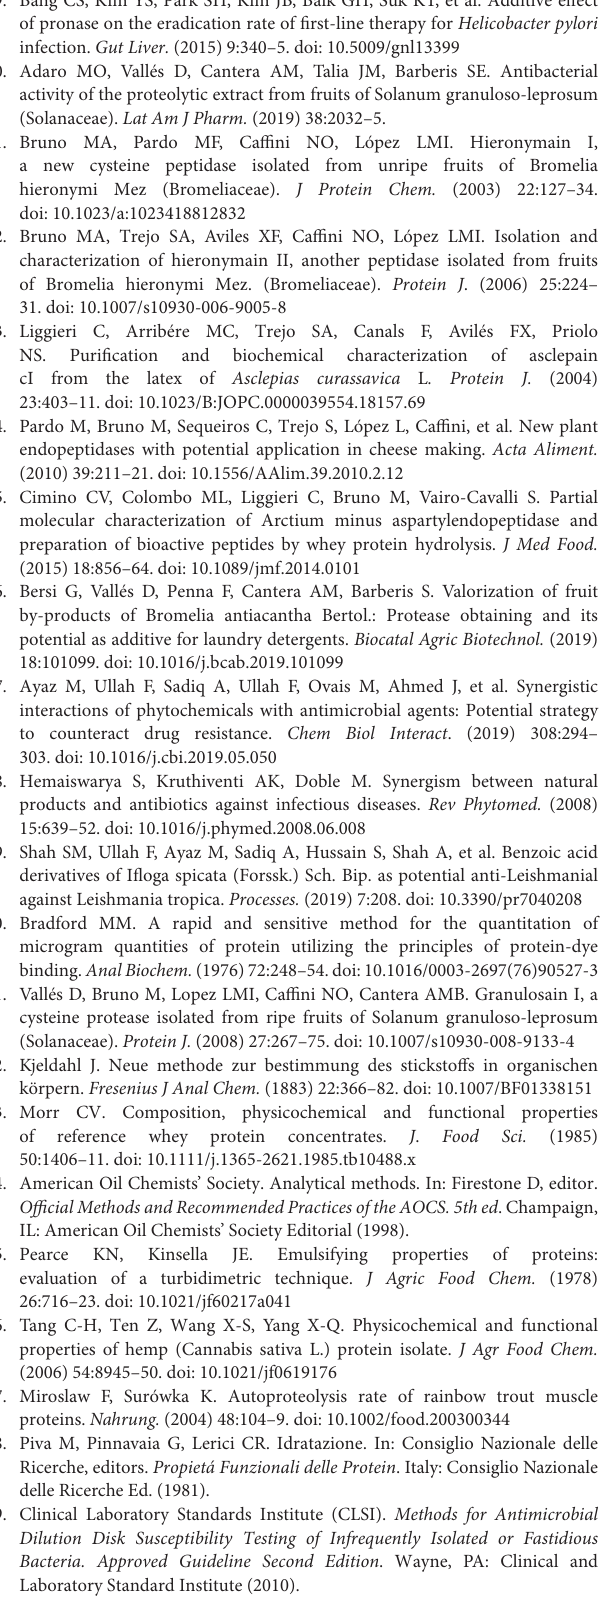
Figueiredo C, et al. A new role for Helicobacter pylori urease: contributions to angiogenesis. Front Microbiol. (2017) 8:1883. doi: